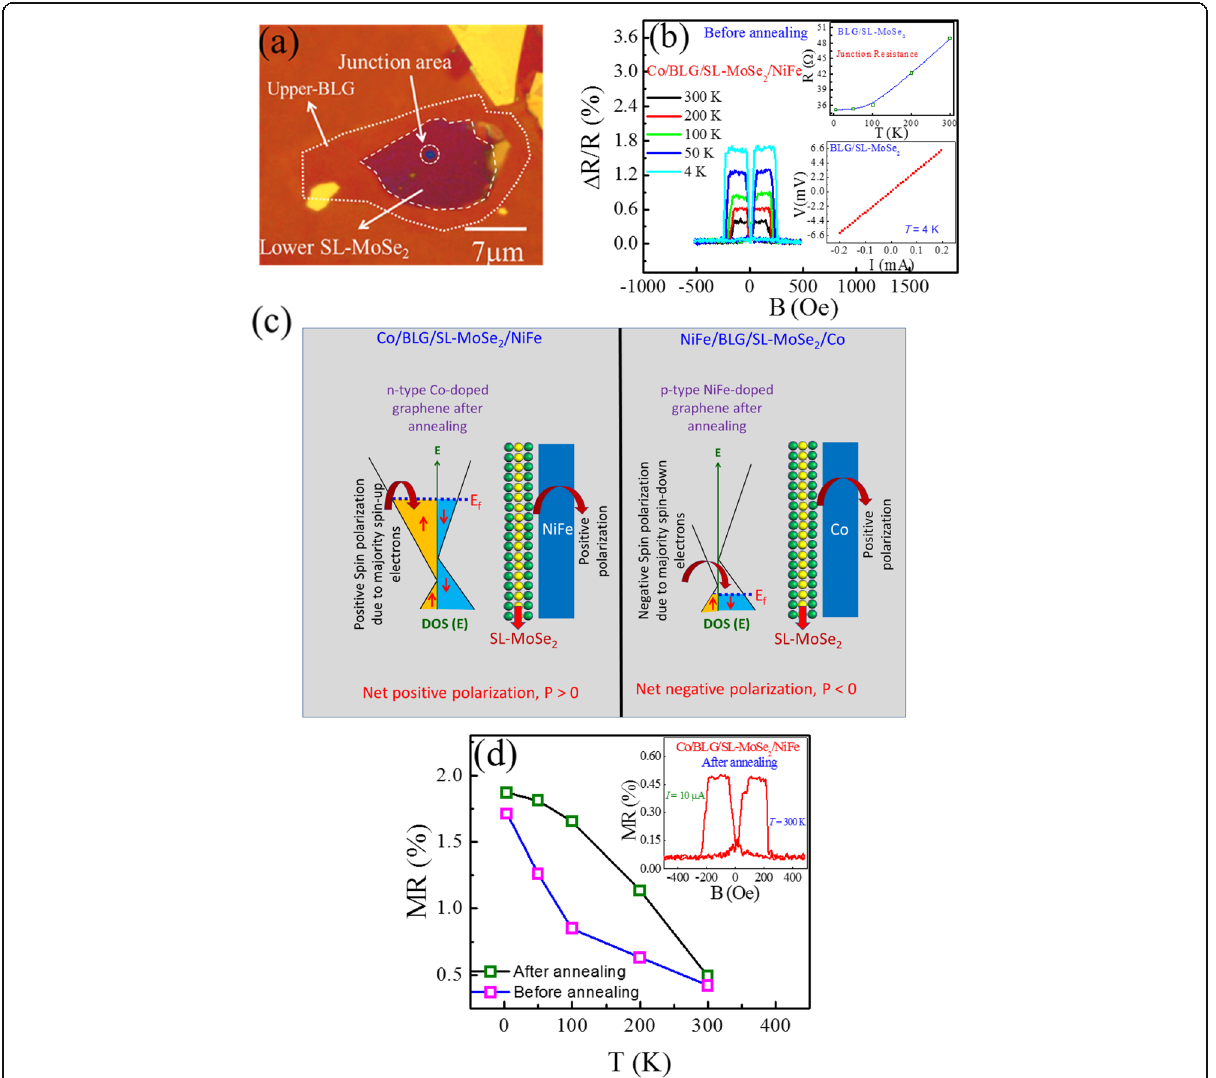
Fig. 3 a Optical microscopic image of BLG/SL-MoSe 2 on a hole. b The temperature-dependent MR loops of Co/BLG/SL-MoSe 2 /NiFe junction at fixed current ( I = 10 μΑ ). (Top-inset) The temperature-dependent junction resistance of Co/BLG/SL-MoSe 2 /NiFe. (Bottom-inset) The linear I-V curve of Co/BLG/SL-MoSe 2 /NiFe device at T = 4 K. c Schematic drawing of spin-dependent density of states for BLG and SL-MoSe 2 heterostacks. After annealing the devices, the Fermi levels of BLG adjacent to the Co or NiFe are shifted due to n-type or p-type doping. d Before and